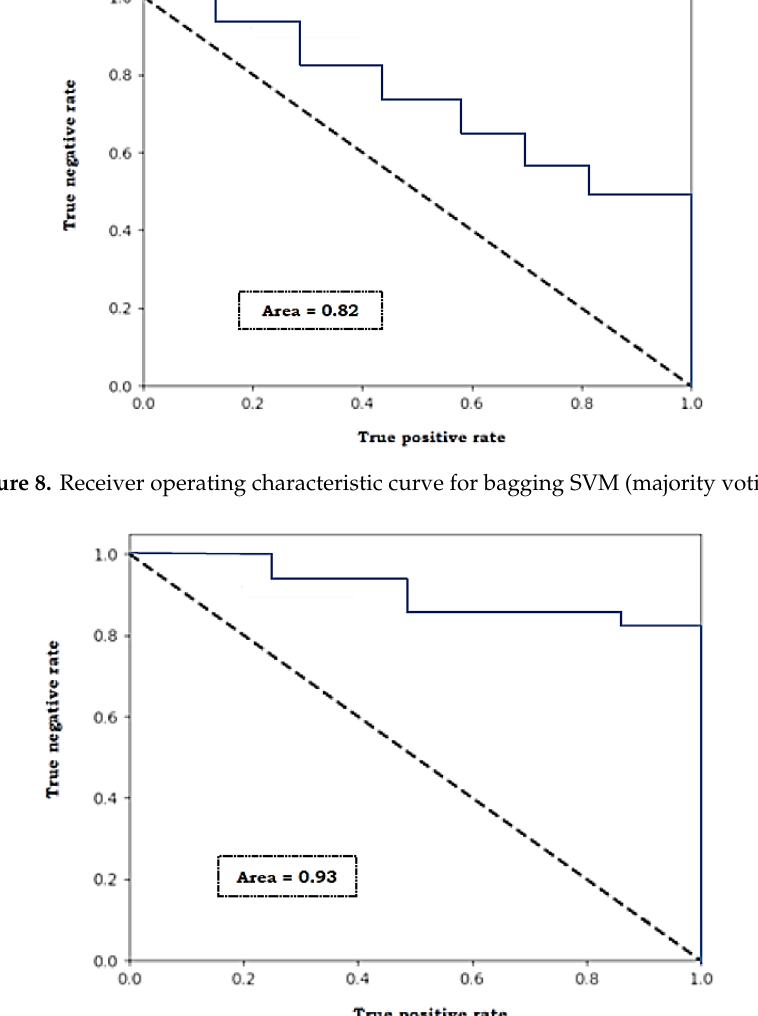
Figure 10. Stability comparison between the integrated SVM classifier and the member classifiers. 4. Conclusion In this study, we proposed an effective ensemble-based classification model, integrated multistage support vector machine classification model for enhancing the predicting accuracy of UD. As the first step, we cleaned the data with MICE for handling the missing values. Then we implemented SVM RFE, a wrapper-based feature selection technique in order to reduce the feature dimension and select the necessary features, which are not dependent on each other, which eventually improves the accuracy of the model. The initial number of features in the original dataset was 22 on which the feature selection technique was applied. We used a 75-25 composition for training and testing datasets. The results proved that the proposed methodology had improved the prediction accuracy of UD when compared with other classification models. It could be observed that the proposed model was better than all other compared approaches in terms of performance and also offered greater accuracy. Author Contributions: Conceptualization, K.S., N.M. and D.R.V. ; Methodology, K.S. and N.M.; Software, K.S.; Validation, C.-Y.C. and S.S.-A.; Formal Analysis, K.S.; Investigation, K.S.; Resources, C.-Y.C. and S.S.-A.; Data Curation, N.M. and D.R.V.; Writing—Original Draft Preparation, K.S.; Writing—Review & Editing, K.S., N.M., C.-Y.C., and S.S.-A; Visualization, K.S.; Supervision, C.-Y.C.; Project Administration, C.-Y.C. and S.S.-A.; Funding Acquisition, C.-Y.C. and S.S.-A. All authors have read and agreed to the published version of the manuscript.